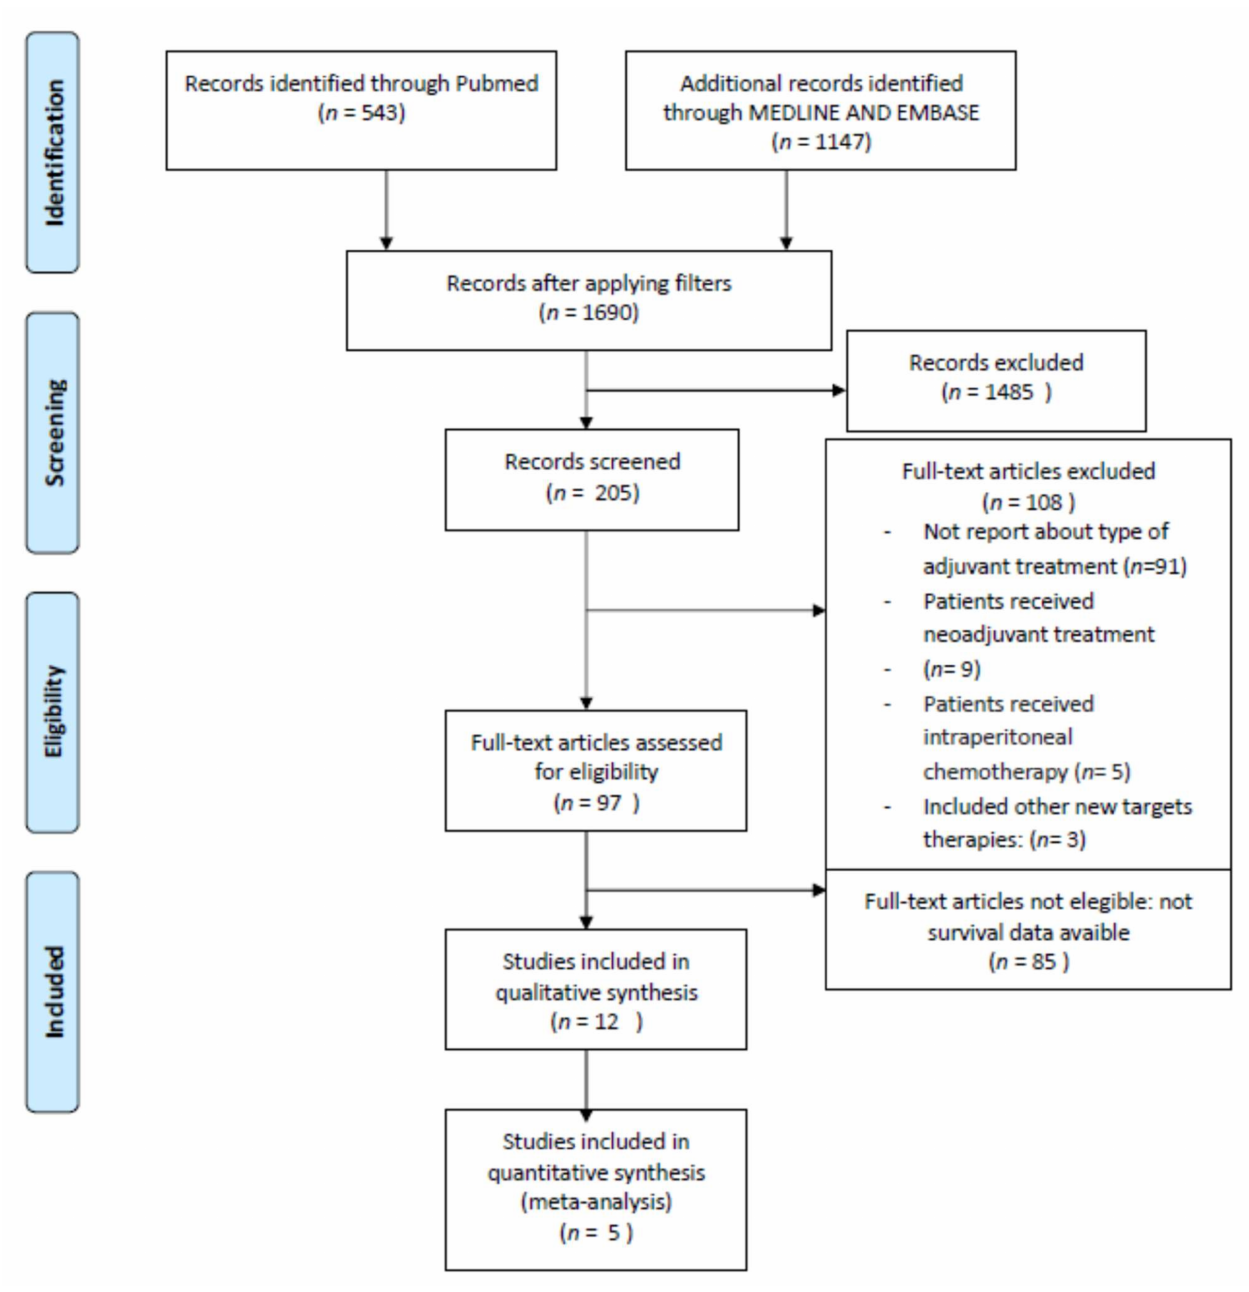
Figure 1. PRISMA Flow